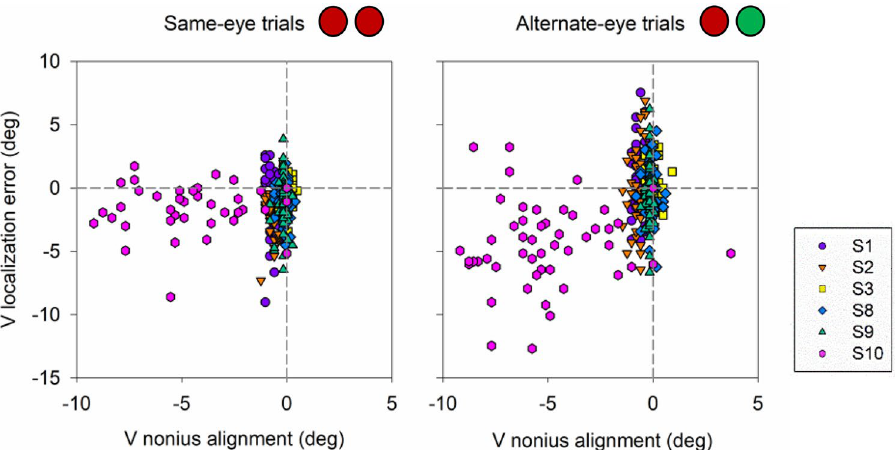
Figure 11. Scatter plot displaying trial by trial correlation, of every 5th trial, between vertical nonius alignment and vertical localization error (n = 6) for same-eye and alternate-eye viewing conditions. Each color and shape represents the data for each trial performed by each